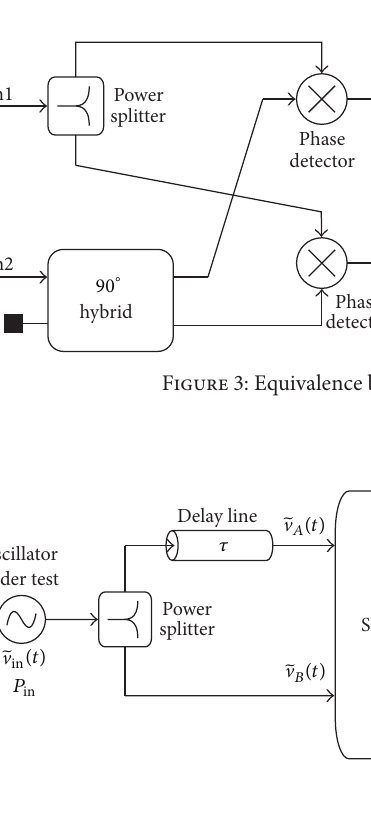
Figure 4: Six-port-based delay line discriminator